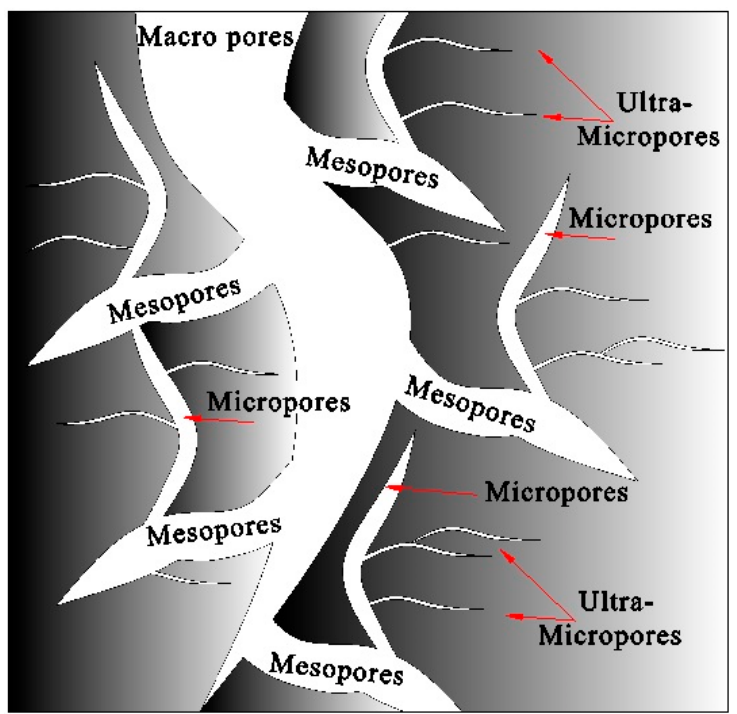
Figure 5. Pictorial description of various pores for electrochemical hydrogen storage.